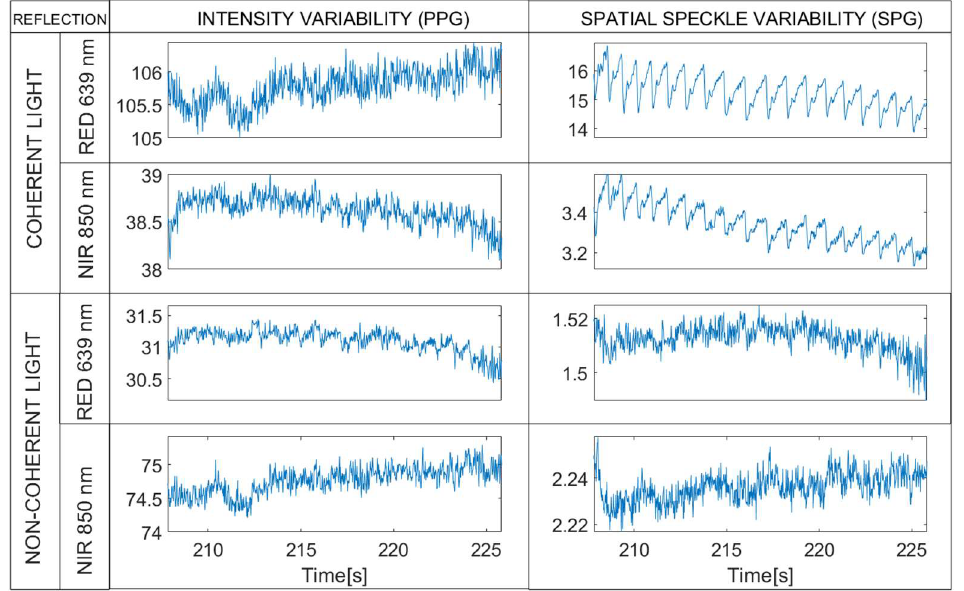
Figure 5. Reflective mode. Raw synchronous R-rPPG ( left ) and R-rPPG ( right ) signals extracted from the 4 multiplexed light sources (1200 μs integration time). As expected, good SPG quality was observed when laser light sources are used. Note that raw waveforms are displayed without vertical inversion—PPG and SPG synchronous signals from a random subject with 1200 µ s integration time.